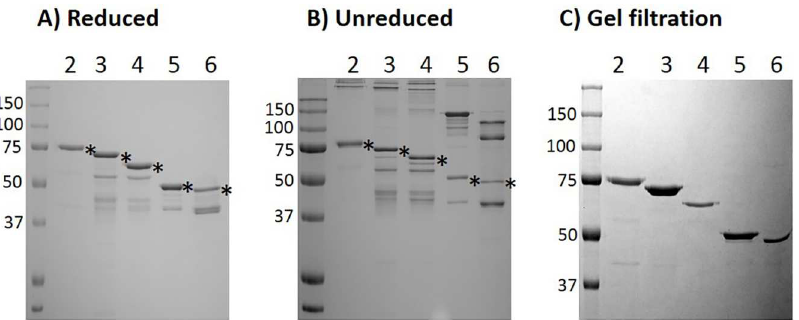
Fig 2. SDS-PAGE analysis of affinity-purified MBP-MSTNpro proteins. Solublefractions of E . coli cell lysates from inducedcultures were subjectedto amylose-resin affinity column. Elution fractions were pooled and subjectedto 12.5% SDS-PAGE gel, followedby Coomassie blue staining.Asterisks indicate affinity- purifiedMBP-MSTNpro proteins. Lanes2, 3, 4, 5, and 6 indicateMBP-MSTNpro, MBP-Pro42-218,